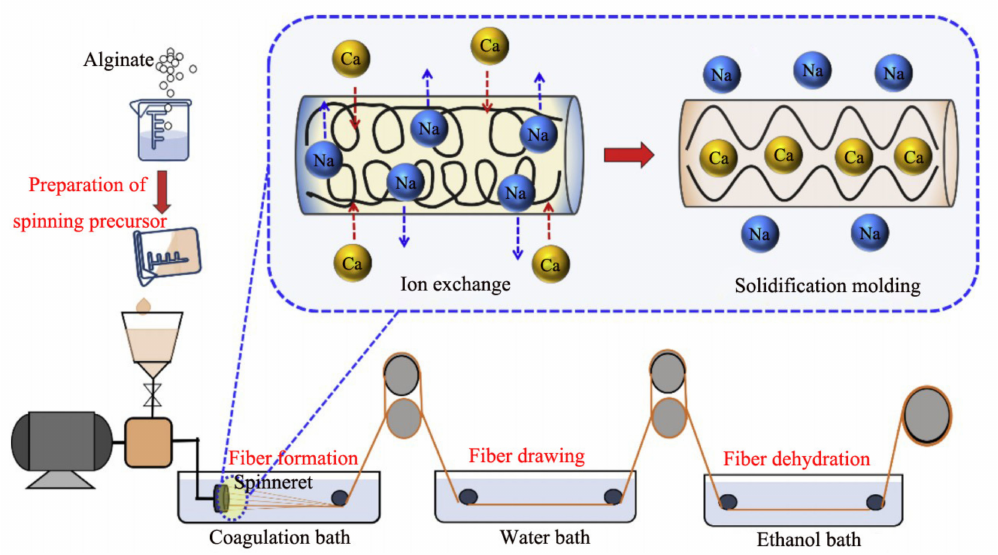
Figure 5. Schematic diagram of wet spinning process of calcium alginate fiber.